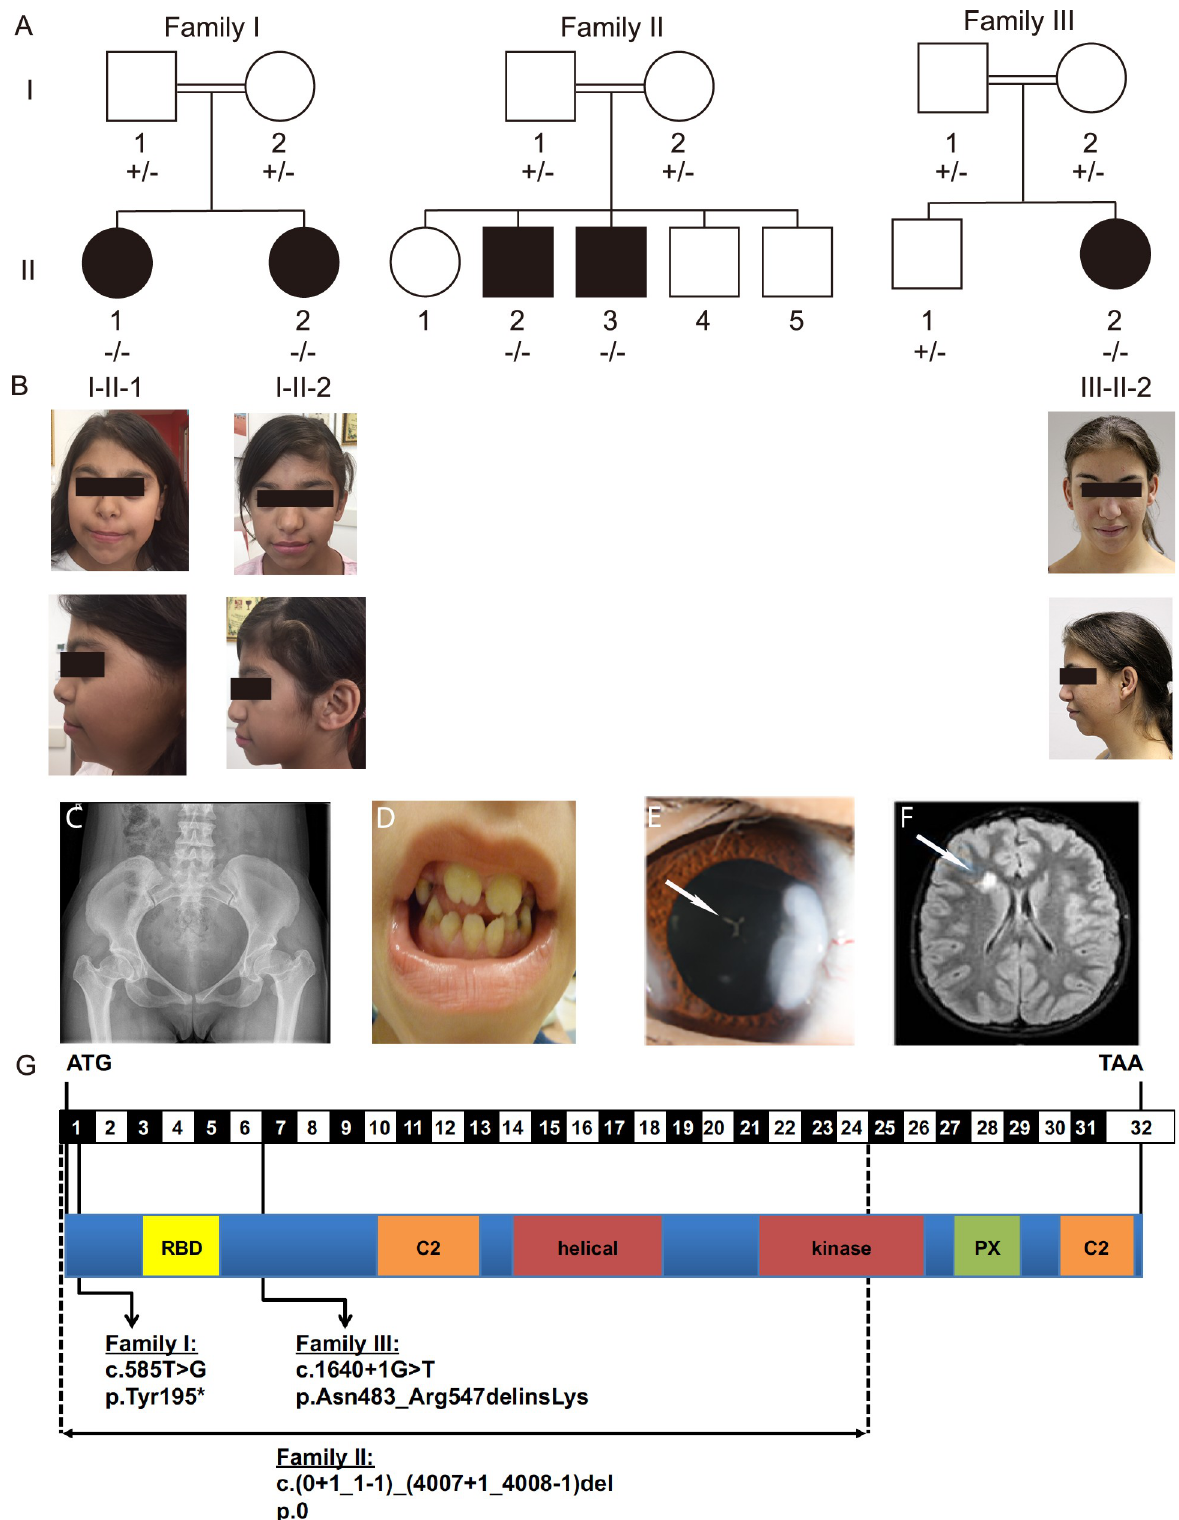
Fig 1. Pedigrees and pictures of the individuals studied. (A) Pedigree of three consanguineous families studied. Black boxes indicated affected individuals. Roman numerals indicating the generation are on the left and Arabic numerals indicating the individual are below each pedigree